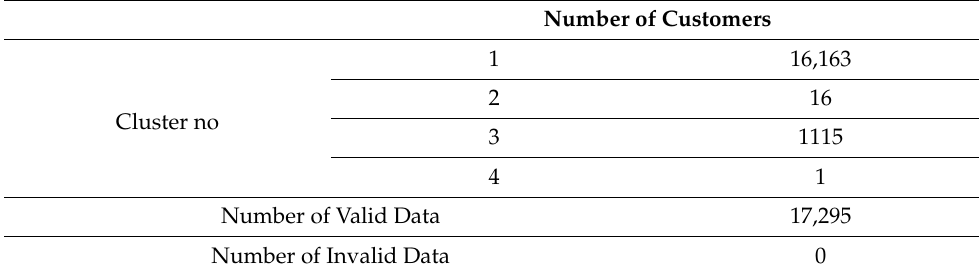
Table 8. Number of customers at any cluster, card code (source: research